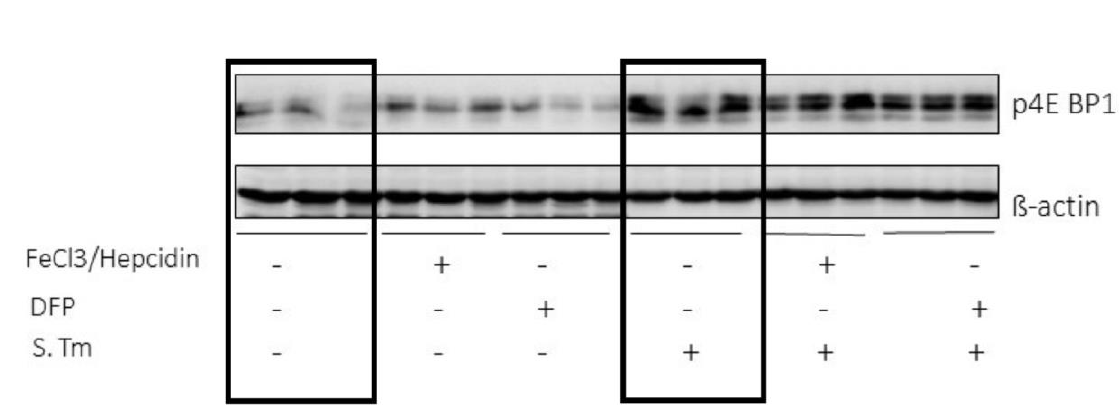
FIGURE 4: Infection but not iron perturbations induces mTOR activation in macrophages . Protein levels of the mTOR downstream target p4E-BP1 were determined using Western blot analysis after treating RAW264.7 cells with Salmonella (MOI of 10) for 1 h. Additionally, cells were treated with FeCl3/hepcidin (50 µM/1 µg/ml, respectively) or DFP (50 µM) for 6 h prior to